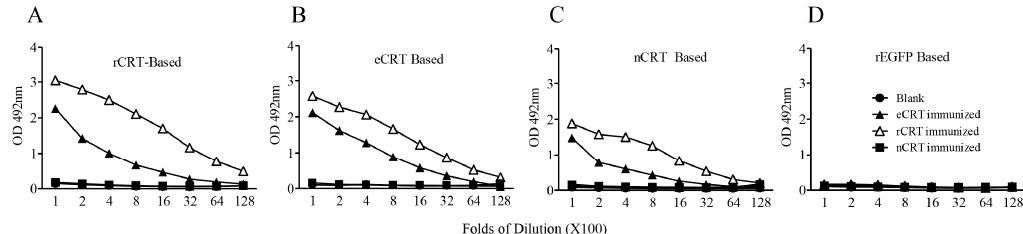
Figure 2. Immunogenicity of eCRT, nCRT and rCRT in mice. SDS-PAGE gel slices containing bands of rCRT, eCRT and nCRT were used as antigens for s.c. immunization of C57/BL6 mice (100 µg/mouse, n = 5) and boosted with 50 µg of the same antigen preparations a fortnight later, with blank gel slices as negative control (Blank). The mice were bled 10 days thereafter for sera that were assayed, in triplicate wells, in ELISAs based on rCRT ( A ), eCRT ( B ), nCRT ( C ) or rEGFP ( D ). The detection Ab was HRP-conjugated goat-anti-mouse IgG with OPD as substrate, and the results are expressed as mean OD492 nm ± SD of three replicates. These are representatives of three independent experiments using proteins from different bulks of purifications.